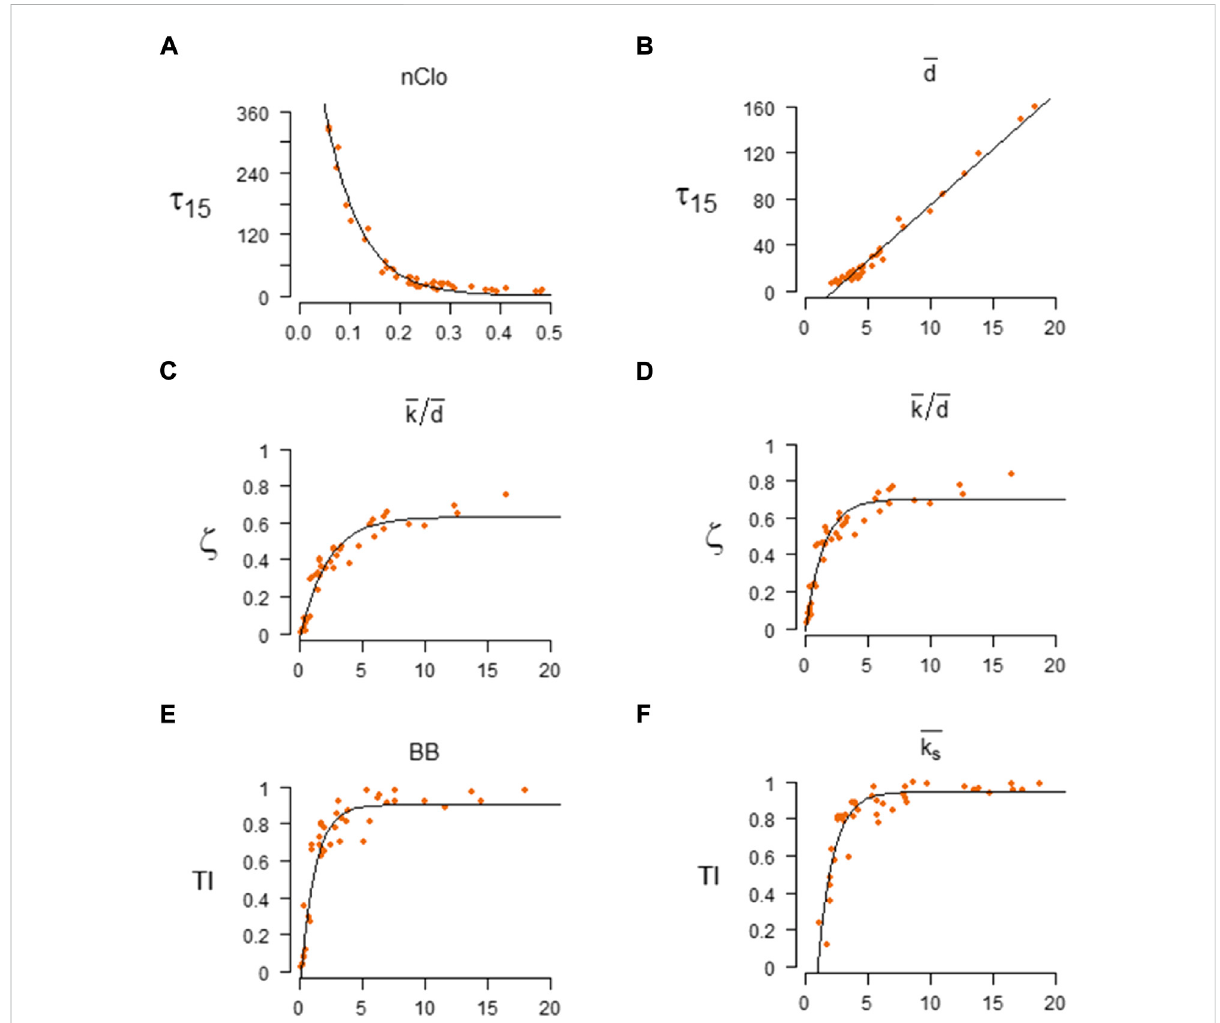
FIGURE 1 ThebestregressionmodelsoftheNetworkStructuralindexes(NSI)vs.SpreadingIndicators(SI).Leftcolumn:thebestregressionmodelsforSIR parameters β =0.03and γ =0.04.Rightcolumn:thebestregressionmodelsforSIRparameters β =0.06and γ =0.04.Bestfor τ 15 : (A) τ 15 asafunction oftheaveragenormalizednodecloseness nClo ;therelationshipisdescribedbyanexponentialmodel τ 15 (cid:1) a · e − b · nCLO witha=751.31andb= − 14.38 (FVU = 0.026); (B) τ 15 as a function of the average node distance (cid:1) d ; the relationship is described by a linear model τ 15 (cid:1) a · (cid:1) d + b with a = 9.66, b = − 21.86 (FVU = 0.02). Best for ζ : (C) Non-linear regression of ζ vs. (cid:1) k / (cid:1) d index; the relationship is described by a mono-molecular function model ζ (cid:1) a · ( 1 − b · e − c ·( (cid:1) k / (cid:1) d ) ) witha=0.63,b=1.05andc=0.46(FVU=0.078); (D) Non-linearregressionof ζ vs. (cid:1) k / (cid:1) d